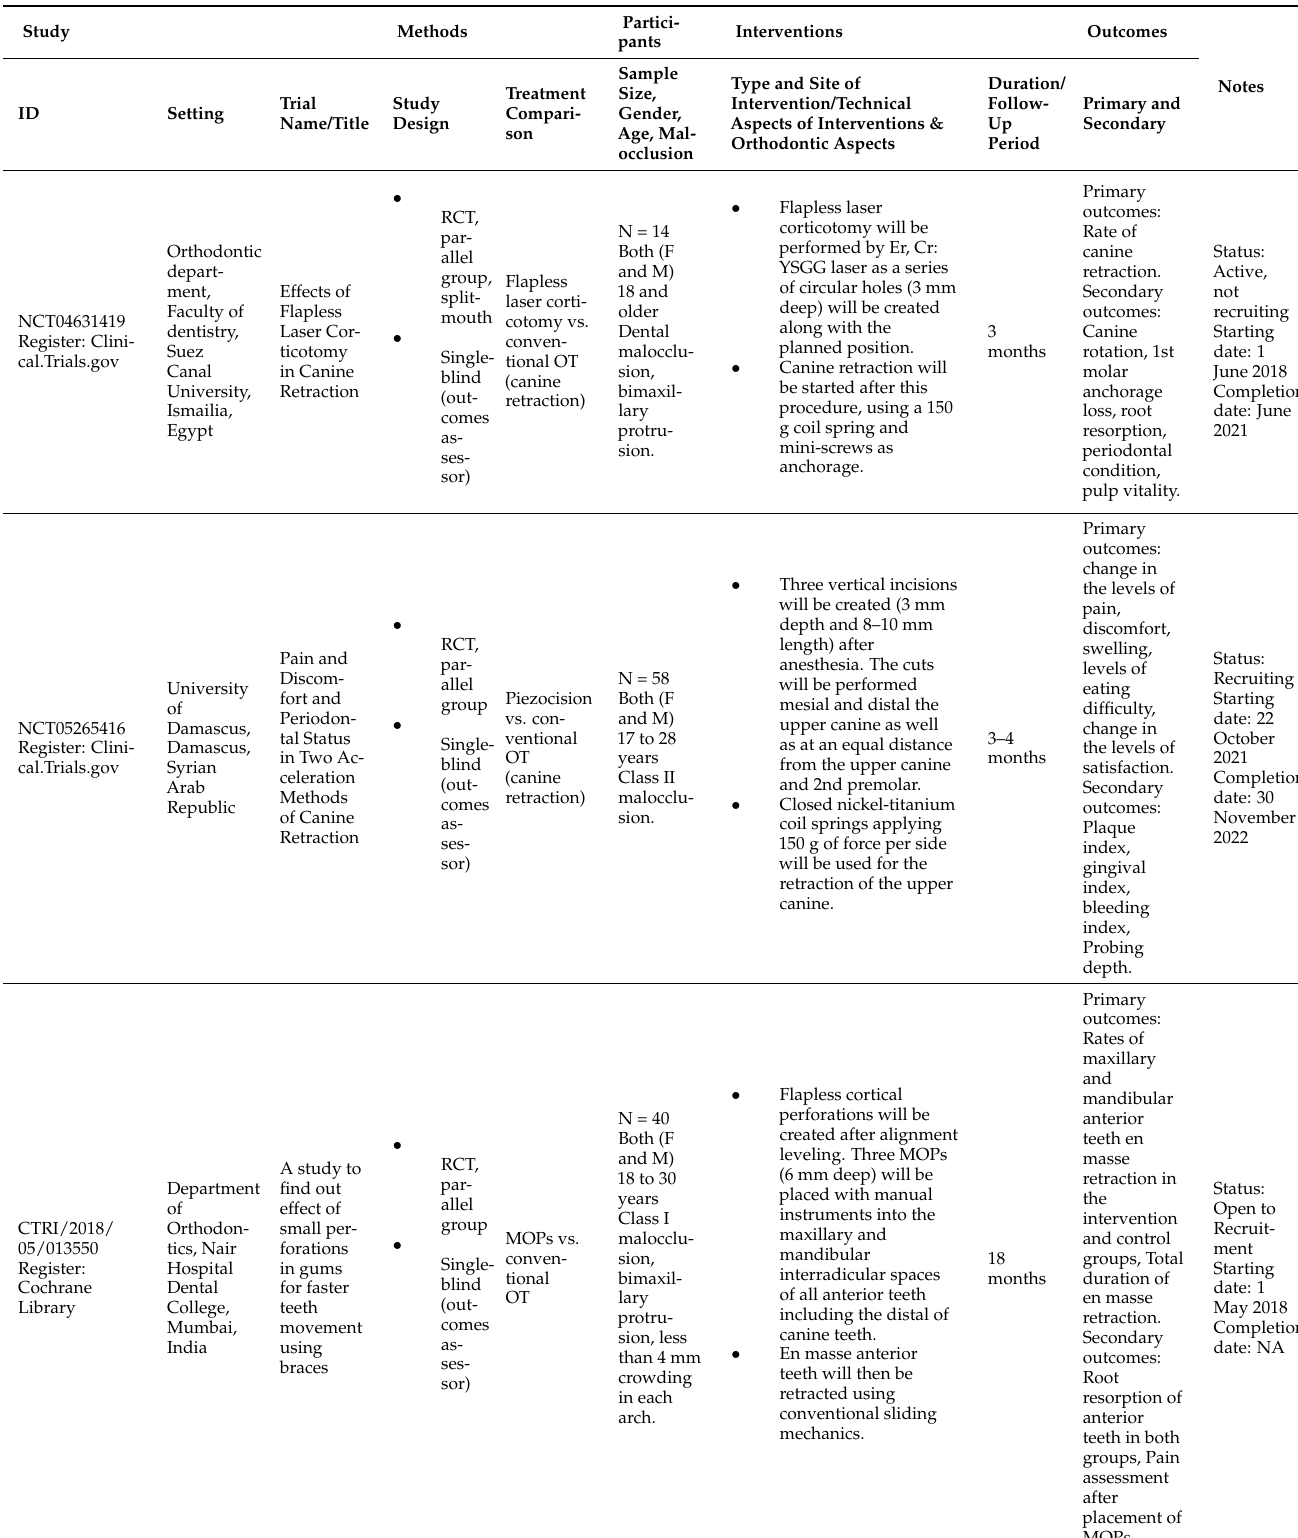
Table A2. Protocols of the ongoing studies registered at the Clinical.Trials.gov and the Cochrane